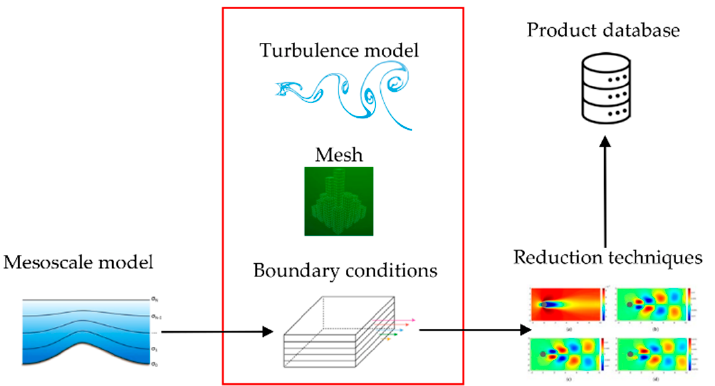
Figure 3. Diagram showing the relationship between the different components of the proposed solution.